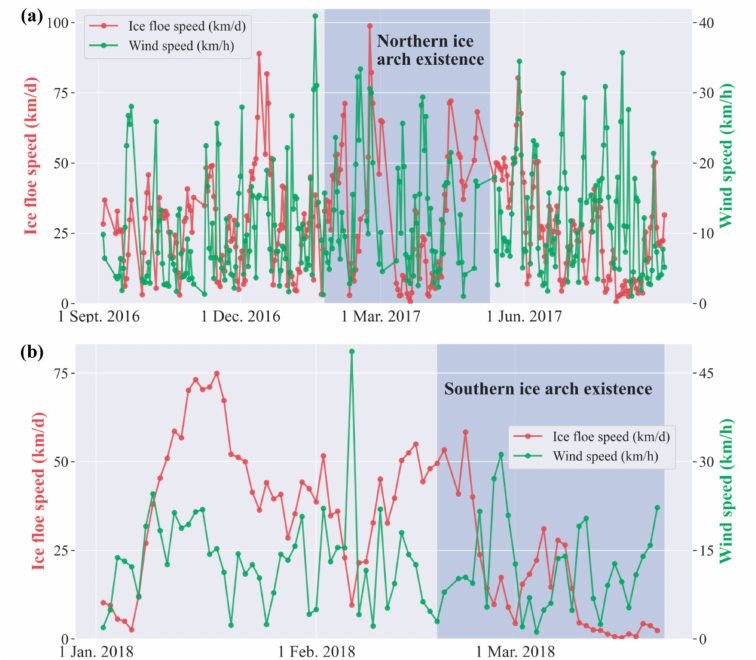
Figure 2. Daily ice floe speed from Sentinel-1 images and the wind speed. ( a ) The ice floe speed and wind speed from September 2016 to August 2017. ( b ) The ice floe speed and wind speed from January 2018 to March